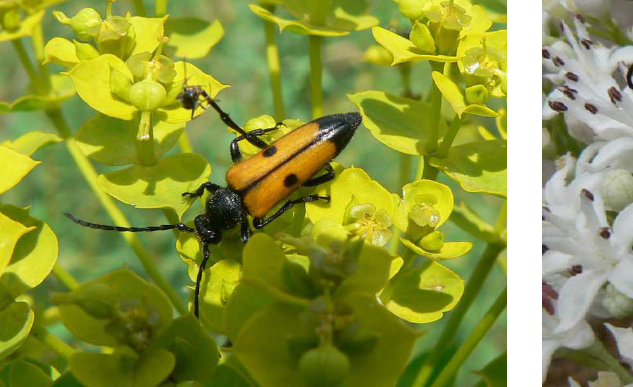
Figure 3. Vadonia moesiaca (Daniel & Daniel, 1891) (photo: Milan Đ uri ć )